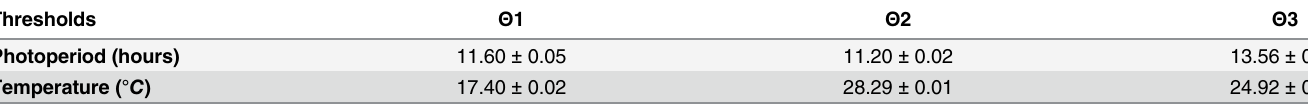
Table 2. Photoperiod (CPP) and temperature ( T crt ) thresholds for each posterior mode.